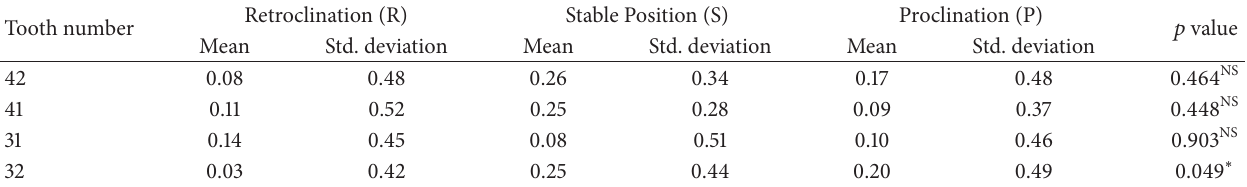
Table 3: The mean increase (mm) of clinical crown height of lower incisors (gingival recession) after treatment (from TB to TA). Tooth